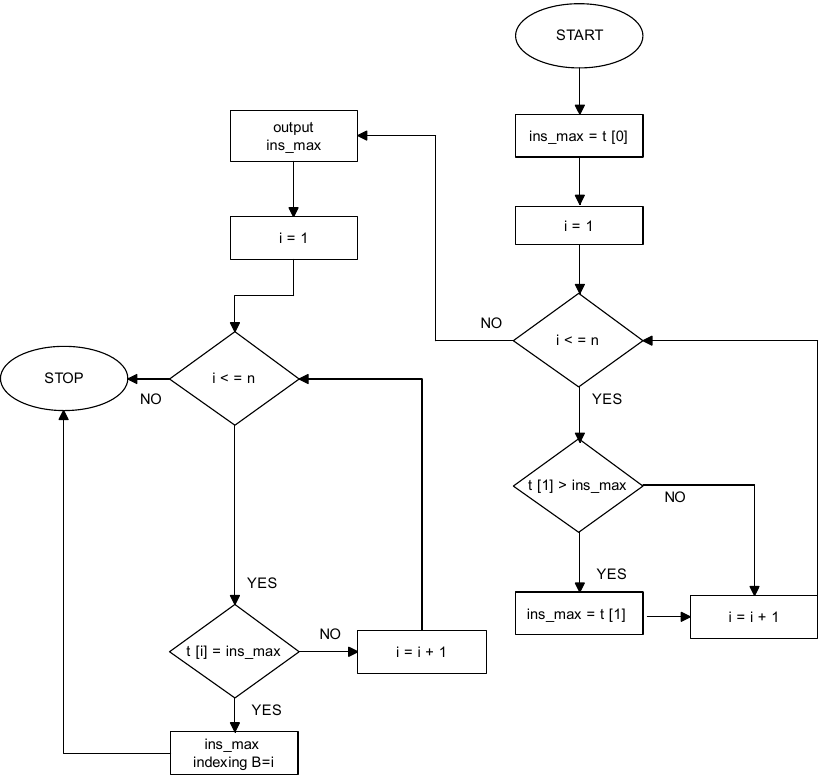
Figure 2. Algorithm for the determination of the angle of inclination of the plane of the photovoltaic modules installed in the fixed structure.